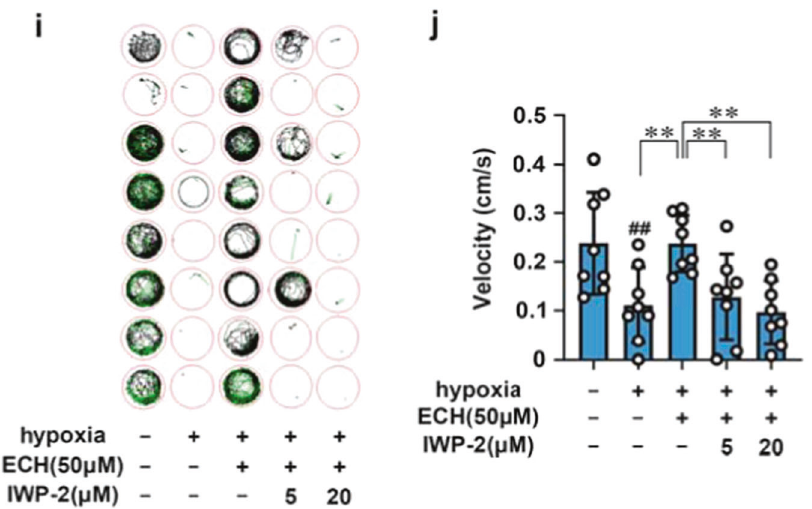
Fig. 6 i , j Swimming performance analysis for ECH and IWP-2 neuroprotection in ischemia/reperfusion-induced zebra fi shes. Data are expressed as the mean ± SD. ## P < 0.01 vs control group. * P < 0.05, ** P < 0.01 vs MCAO group. NS not signi fi cant